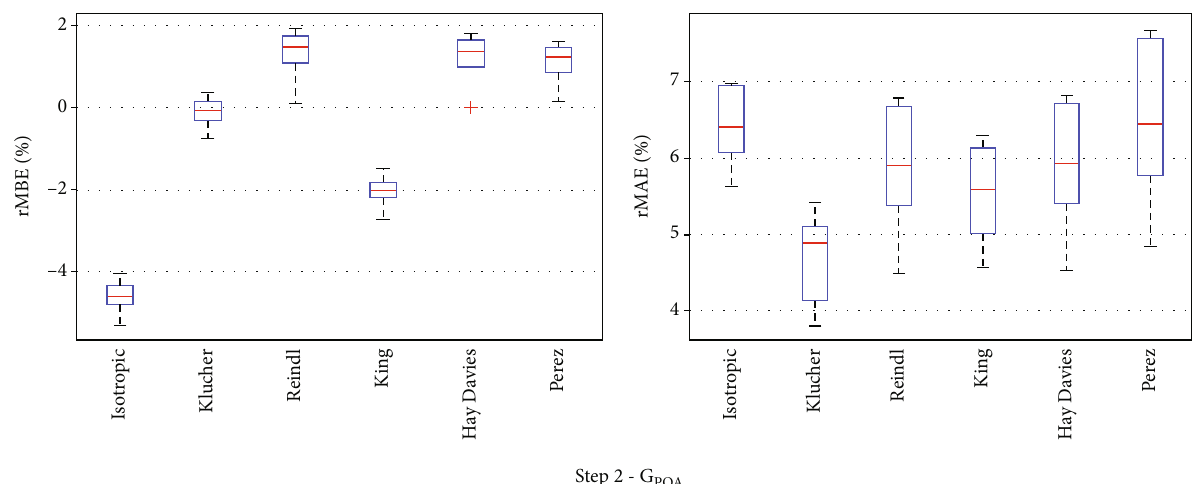
Figure 4: rMBE (left) and rMAE (right) of the presented models to calculate G data are summarized in Figure 9 of Appendix